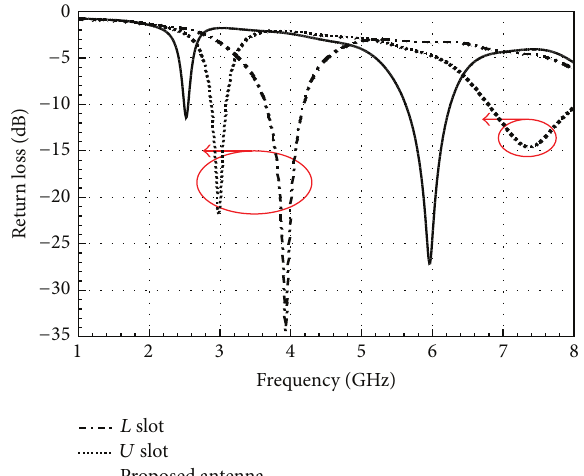
Figure 4: The simulation return losses results for the proposed L, U, and e-shaped slit S-parameter.